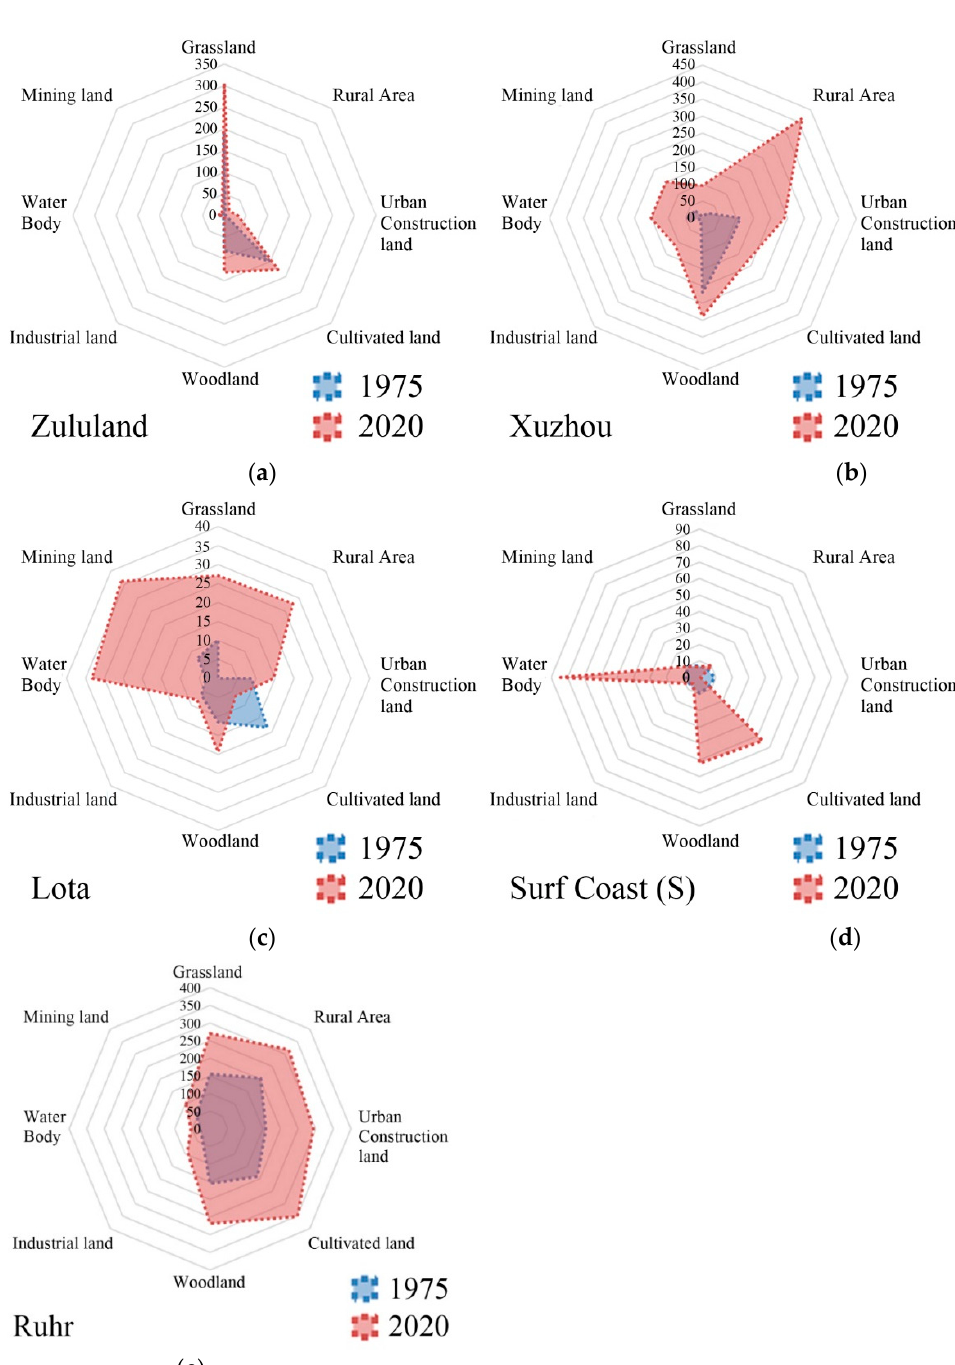
Figure 3. Variation of LSI of five cities from 1975 to 2020 (( a ). Zululand, ( b ). Xuzhou, ( c ). Lota, ( d ). Surf Coast, ( e ). Ruhr). From Table 4, it is clear that the aggregation of production space in Zululand increased significantly (LPI increased by 18.67%). However, the aggregation of production space was seriously damaged (LPI decreased by 16.73%). And Figure 3a shows the LSI of grassland in Zululand has the greatest increase from 1975 to 2020. Therefore, more attention should be paid to the protection of the grassland in Zululand in the future. For Xuzhou, the expansion scale of the living function is a maximum of five cities. However, the aggregation of living space has not been increased (LPI increased by 2.08%), and it leads to serious damage to the aggre- gation of production space (LPI decreased by 20.21%). From Figure 3b, the most important problem is that a number of scattered rural construction land destroys the integrity of the land